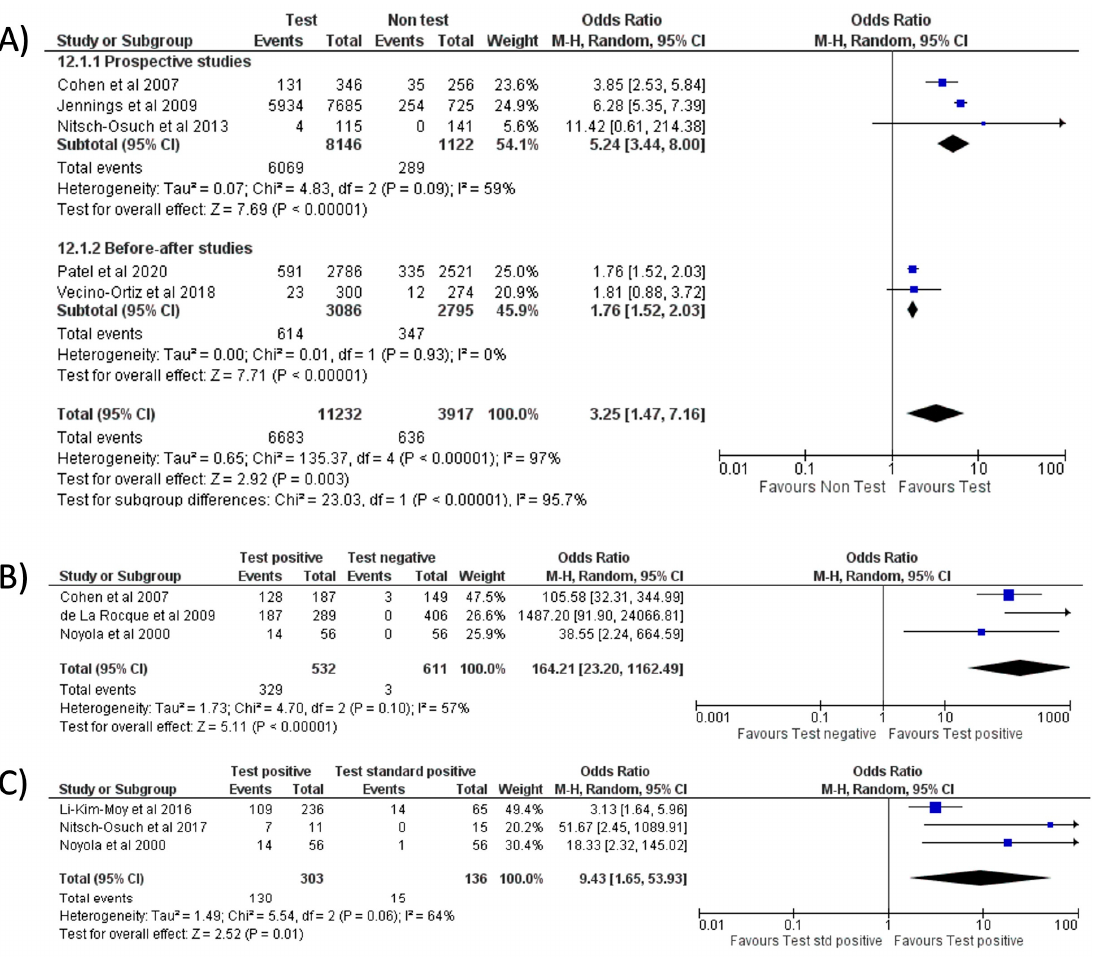
(Figure 7B) [12,28,29] and when evaluating a positive RIDT vs. a positive standard